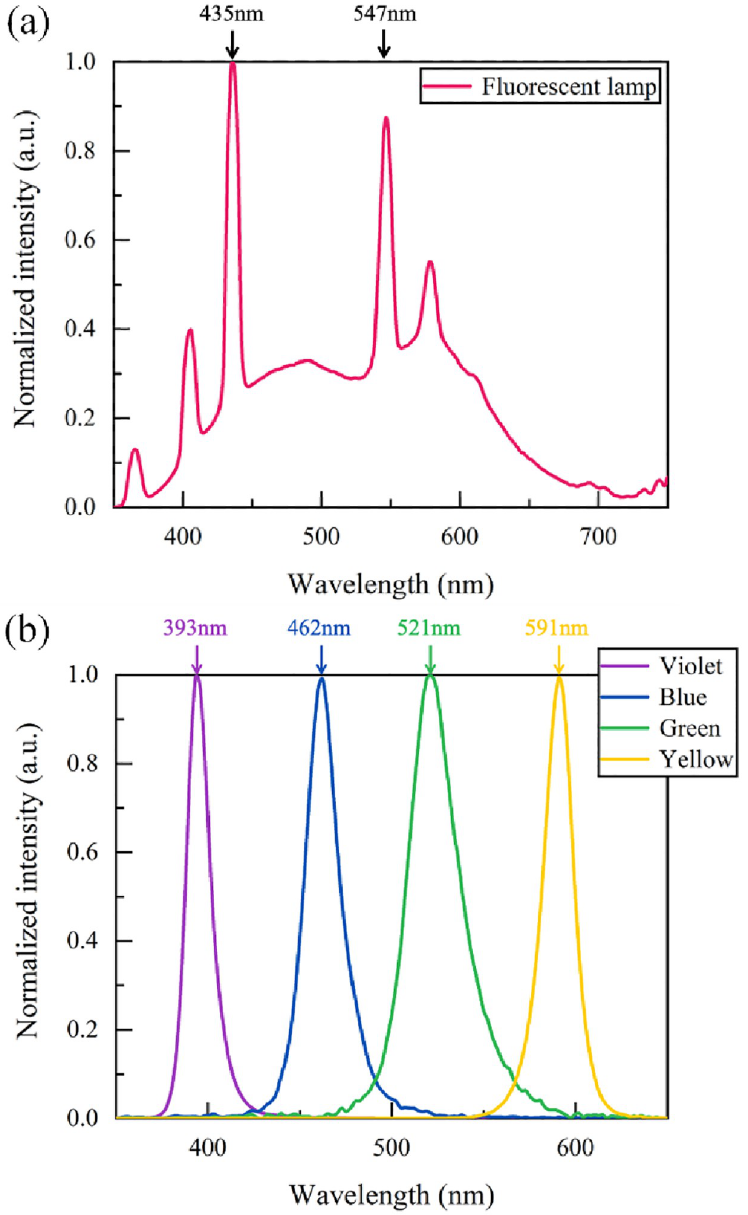
Fig 1. The spectra of the fluorescent lamp and LEDs. (a) The spectrum of the fluorescent lamp. (b) The spectrum of the LEDs. Left to right: violet (FWHM = 15.7 nm), blue (FWHM = 23.7 nm), green (FWHM = 33.9 nm) and yellow (FWHM = 20.5 nm) LEDs. We replaced the fluorescent lamp with the monochromatic LED for the light intervention